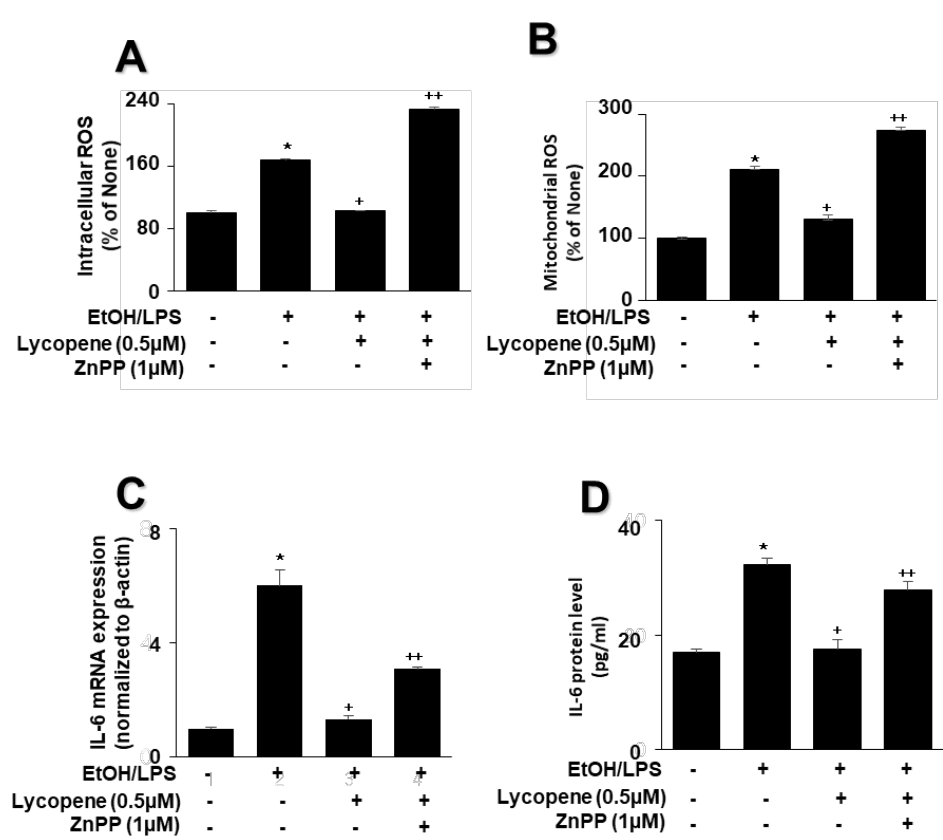
Figure 6. Effect of the HO-1 inhibitor ZnPP on the levels of ROS and IL-6 in ethanol (EtOH)/lipopolysaccharide (LPS)-stimulated and lycopene-treated AR42J cells. Cells (2 × 10 5 /2 mL/well) were pretreated with ZnPP (1 µ M) in the presence of lycopene (0.5 µ M) for 1 h and stimulated with EtOH (at a final concentration of 250 mM)/LPS (10 µ g/mL) for 30 min ( A , B ), 6 h ( C ), or 24 h ( D ). ( A ) Intracellular ROS levels were determined by DCF fluorescence. ( B ) Mitochondrial ROS levels were measured by determining the level of fluorescent MitoSOX. The value for ROS levels in control cells (cells not treated with EtOH/LPS, lycopene, or ZnPP) was set at 100%. ( C ) mRNA expression of IL-6 was determined using real-time polymerase chain reaction and normalized to that of β -actin. The IL-6 mRNA level in control cells (cells not treated with EtOH/LPS, lycopene, or ZnPP) was set as 1. ( D ) Levels of IL-6 in the culture medium were measured by enzyme-linked immunosorbent assay. Data are expressed as the mean ± SE ( n = 12 in each group). * p < 0.05 vs. control cells (cells not treated with EtOH/LPS, lycopene, or ZnPP); + p < 0.05 vs. cells with EtOH/LPS stimulation and without any treatment;. ++ p < 0.05 vs. cells with EtOH/LPS stimulation and lycopene treatment. The cells incubated with tetrahydrofuran (THF, 0.01%) alone served as a vehicle control. For each experiment, lycopene-untreated cells received a vehicle THF (0.01%) alone instead of lycopene. ZnPP was dissolved in dimethyl sulfoxide (DMSO). For each experiment, ZnPP-untreated cells received a vehicle DMSO (0.05%). +,